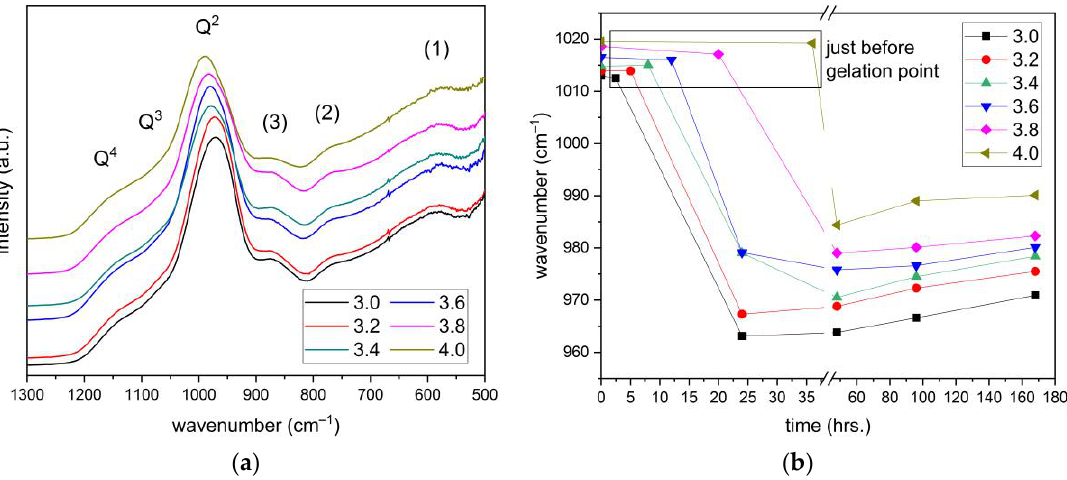
Figure 2. ( a ) Asymmetric stretching vibration bands of silicate entities in lithium silicate gels at the age of 48 h; ( b ) The shift of asymmetric vibration band belonging to Q 2 silicate units as a function of time.